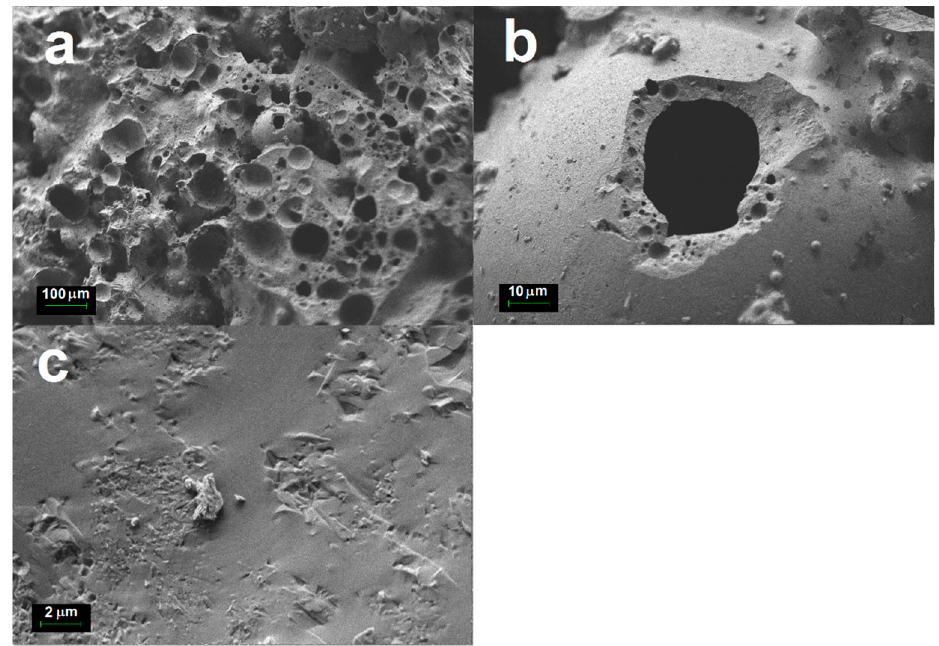
Figure 6. FESEM images showing the ( a ) size distribution of the cenospheres heated at 1400 °C and ( b ) single sphere and ( c ) outer surface of a sphere in closer views.